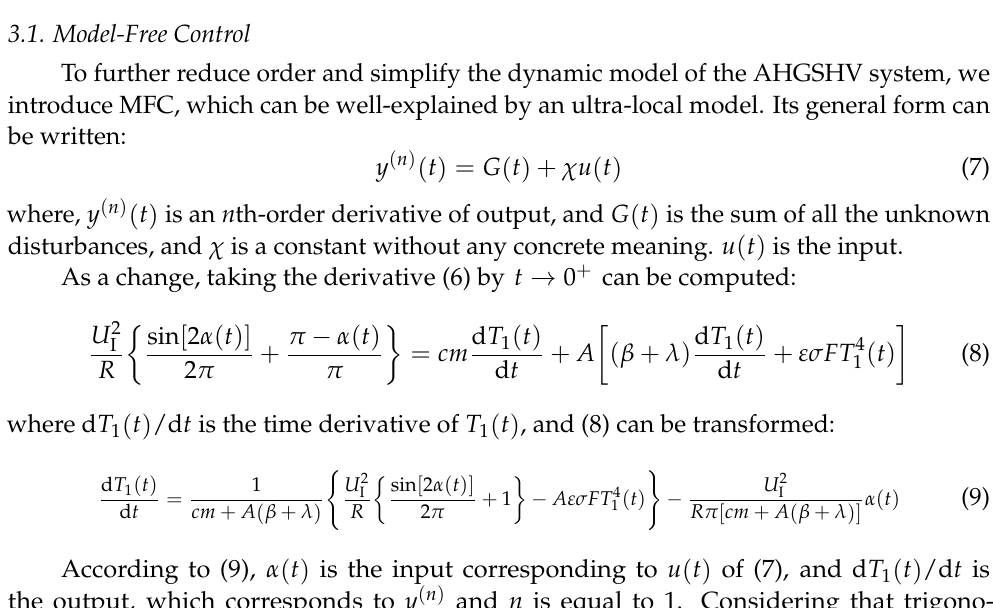
Figure 3. Schematic illustration for the STNFOSMCTDE control